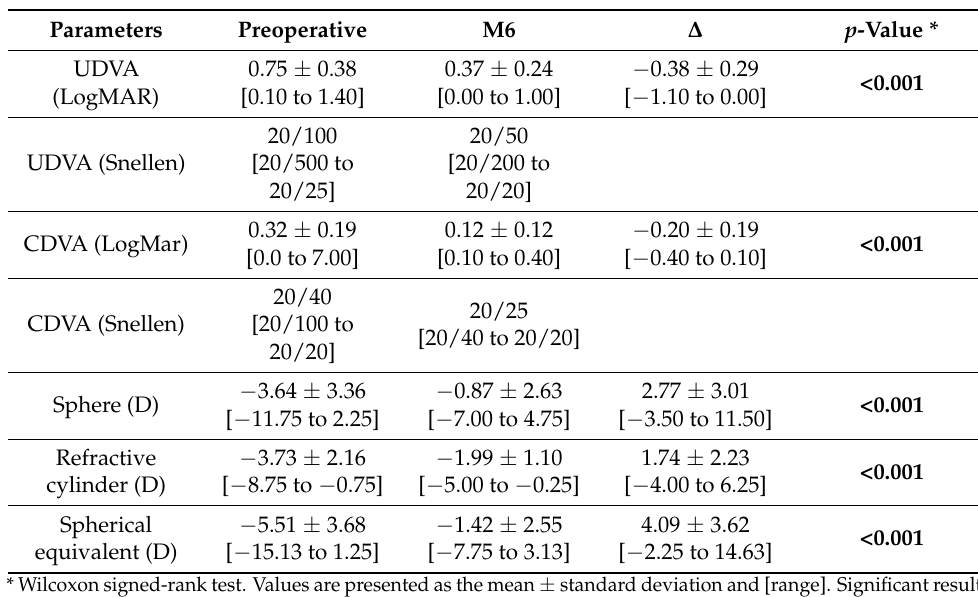
Table 2. Vision and refractive results ( n = 33).